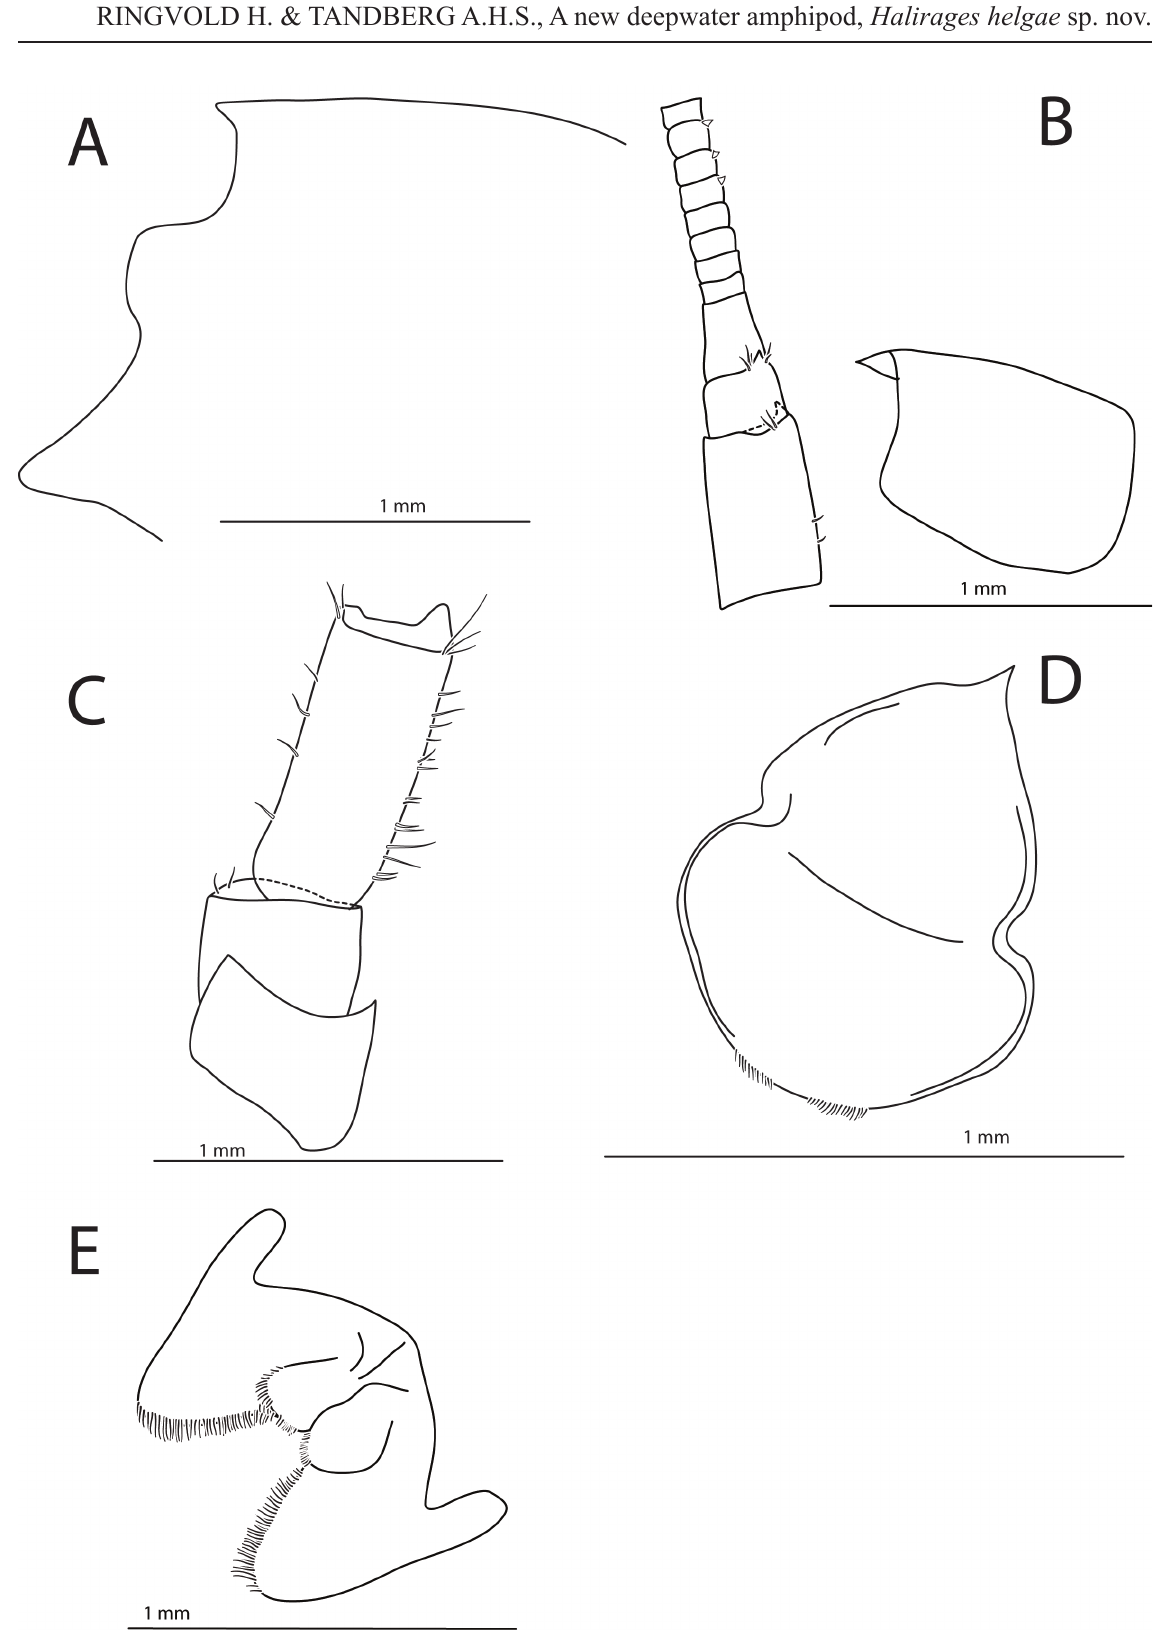
Fig. 3. Halirages helgae sp. nov., holotype, ♀ , 10 mm long. A . Head. B . Antenna 1. C . Antenna 2. D . Upper lip. E . Lower